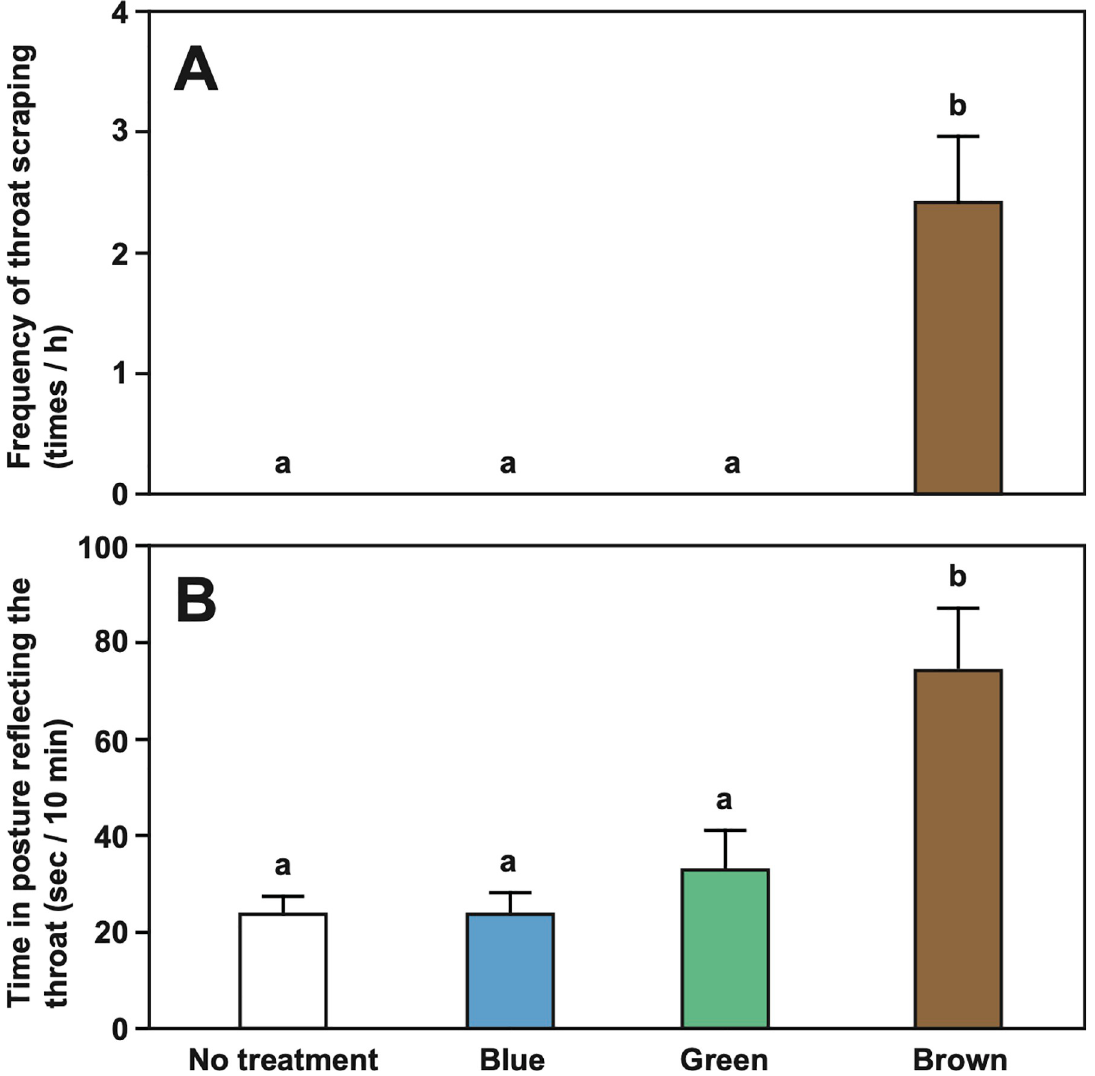
Fig 3. Mean frequency ( ± SEM/h) of throat scraping on the substrate (A) and mean time (sec ± SEM/10 minutes) of position reflecting their throat on a mirror (B) in no treatment, blue mark, green mark, and brown mark by cleaner fish L . dimidiatus in presence of mirror. No throat scrapings were observed in all cases in the absence of mirror, and the results are omitted. See S1 Data for raw data. SEM, standard error of the